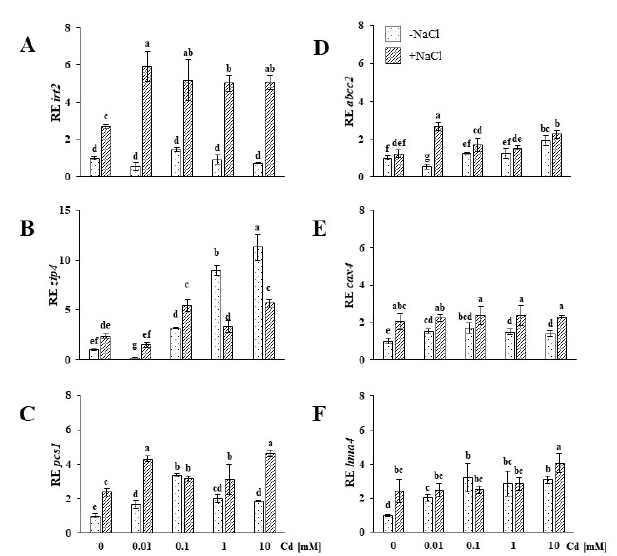
Figure 2. Expression of iron-regulated protein 2, irt2 ( A ), zinc-induced protein 4, zip4 ( B ), phytochelatin synthase 1, pcs1 ( C ), ATP-binding cassette type c 2, abcc2 ( D ), cation exchanger 4, cax4 ( E ), and heavy metal ATPase 4, hma4 ( F ) genes in the roots of soil-grown NaCl-untreated ( − NaCl) and salt-stressed ( + NaCl) Mesembryanthemum crystallinum plants subjected to concentrations of 0.01, 0.1, 1, 10 mM Cd and control (0.0 mM). Di ff erent letters above the bars indicate statistically significant di ff erences at p ≤ 0.05 by Duncan’s post hoc test ( N = 4, mean value ±